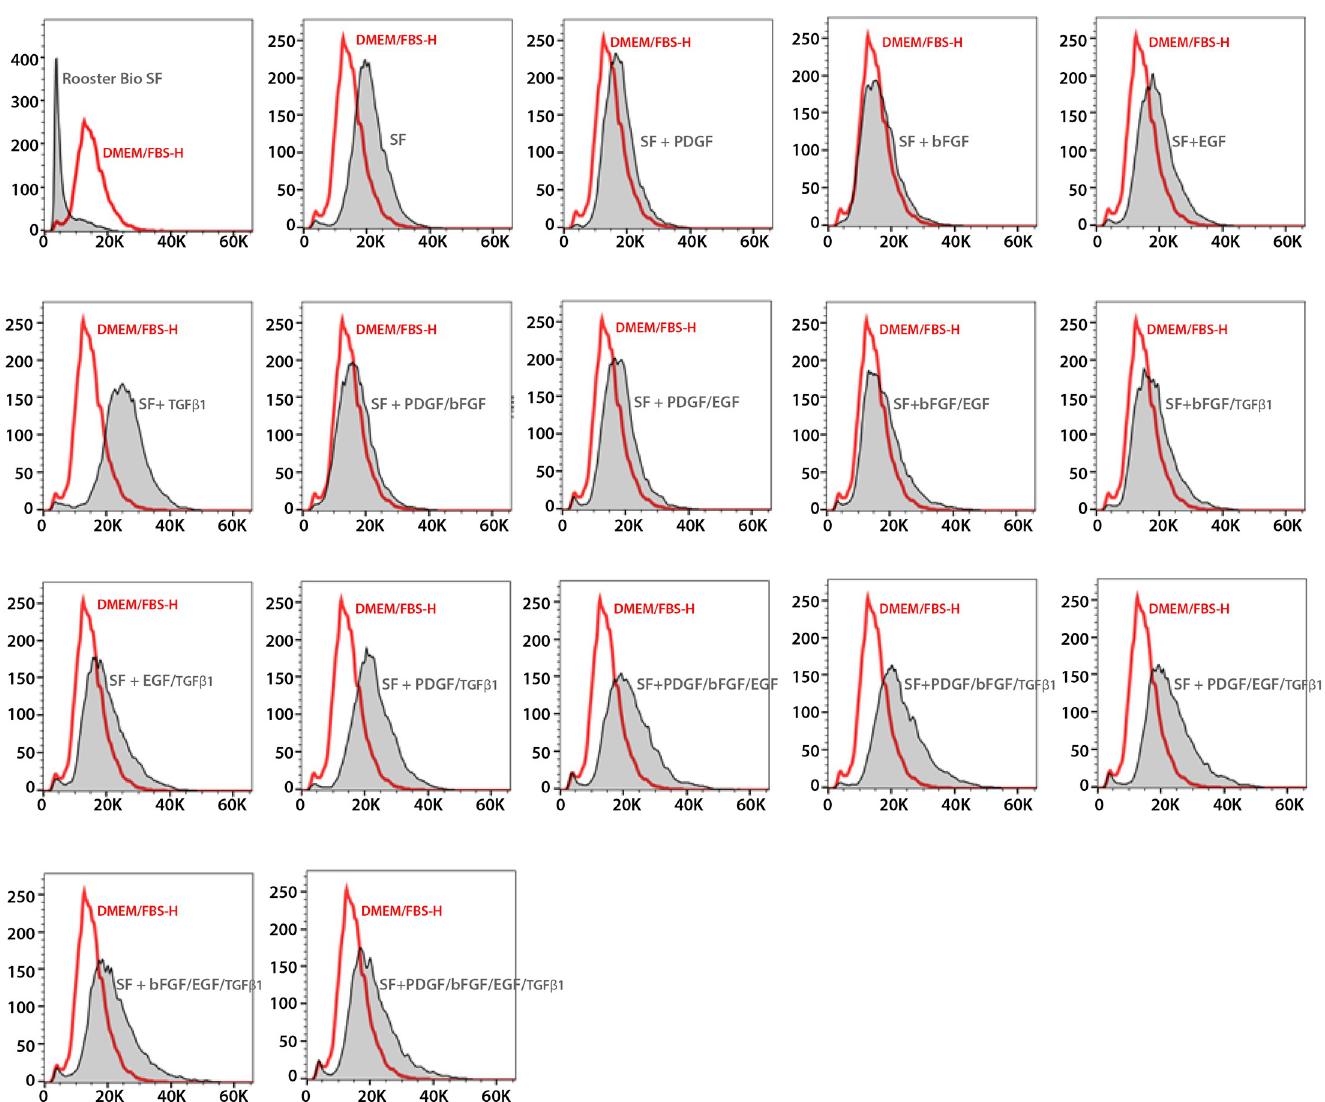
Fig 5. Flow cytometry analysis of canine Ad-MSCs cultivated in DMEM/FBS-H or serum-free medium. Comparison of forward scatters of canine Ad-MSCs cultured in serum-free medium supplemented with the indicated growth factors or DMEM/FBS-H. Y-axis represents mode of the count/number of events and X-axis represents the units of light scatter intensity. SF = na ï ve serum-free